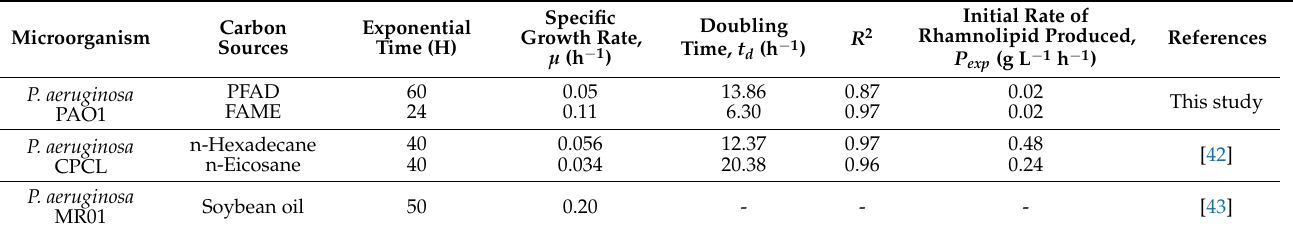
Table 4. Comparison of microbial growth rate and production of rhamnolipid in the exponential phase. Microorganism Carbon